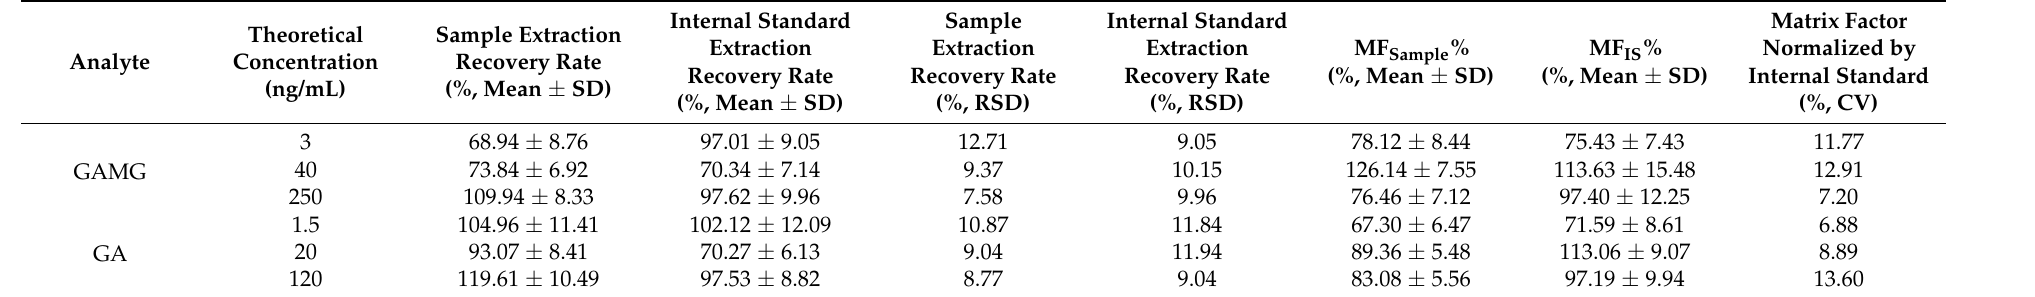
Table 4. Extraction recovery rate and matrix effect of the detection of each analyte ( n = 6).